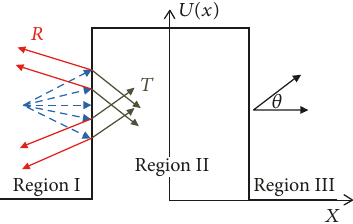
Figure 1: (Color online) Schematically potential profile showing regionsI,II,andIIIandtheirrelationshipbetweentheincidentangle 𝜃 and the eventual transmission 𝑇 and reflection 𝑅 = 1 − 𝑇 through the barrier